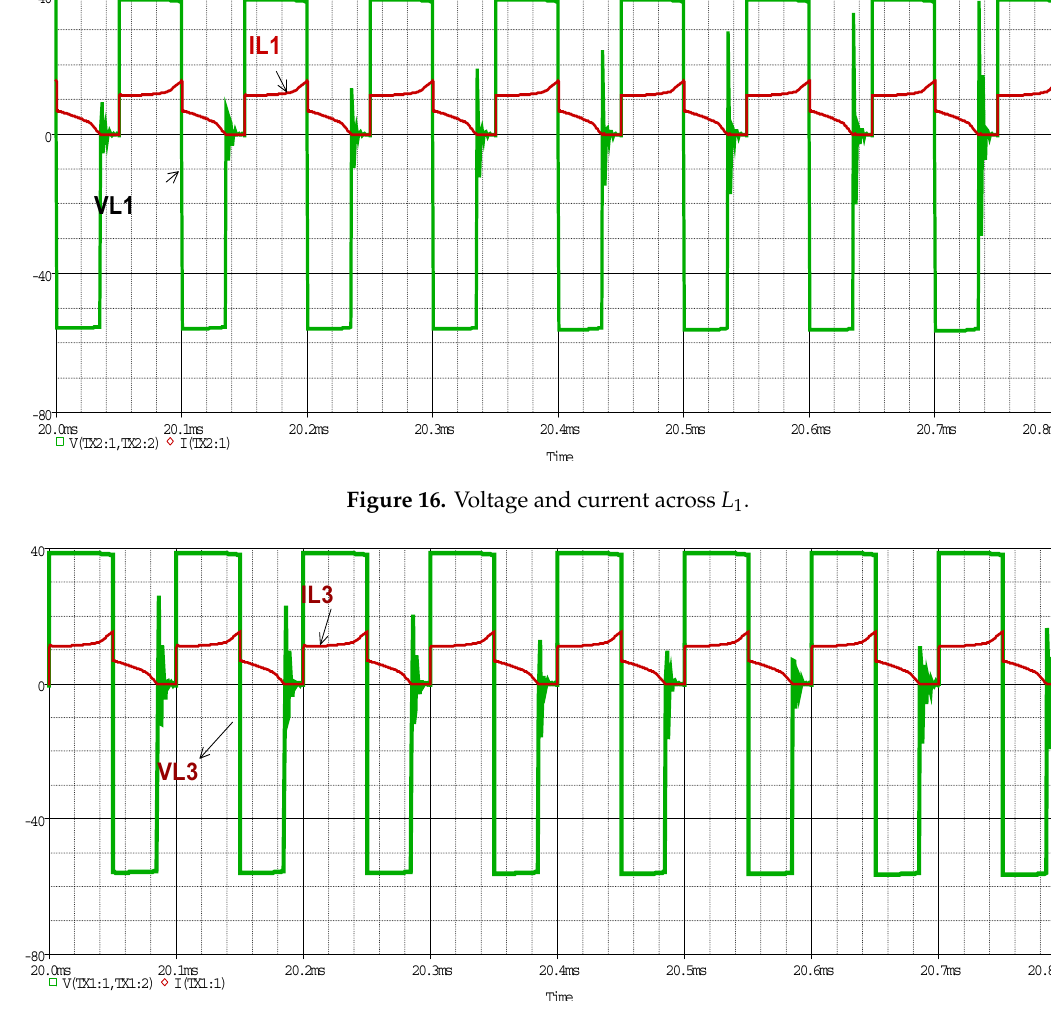
Figure 17. Voltage and current across 𝐿 (cid:2871) .